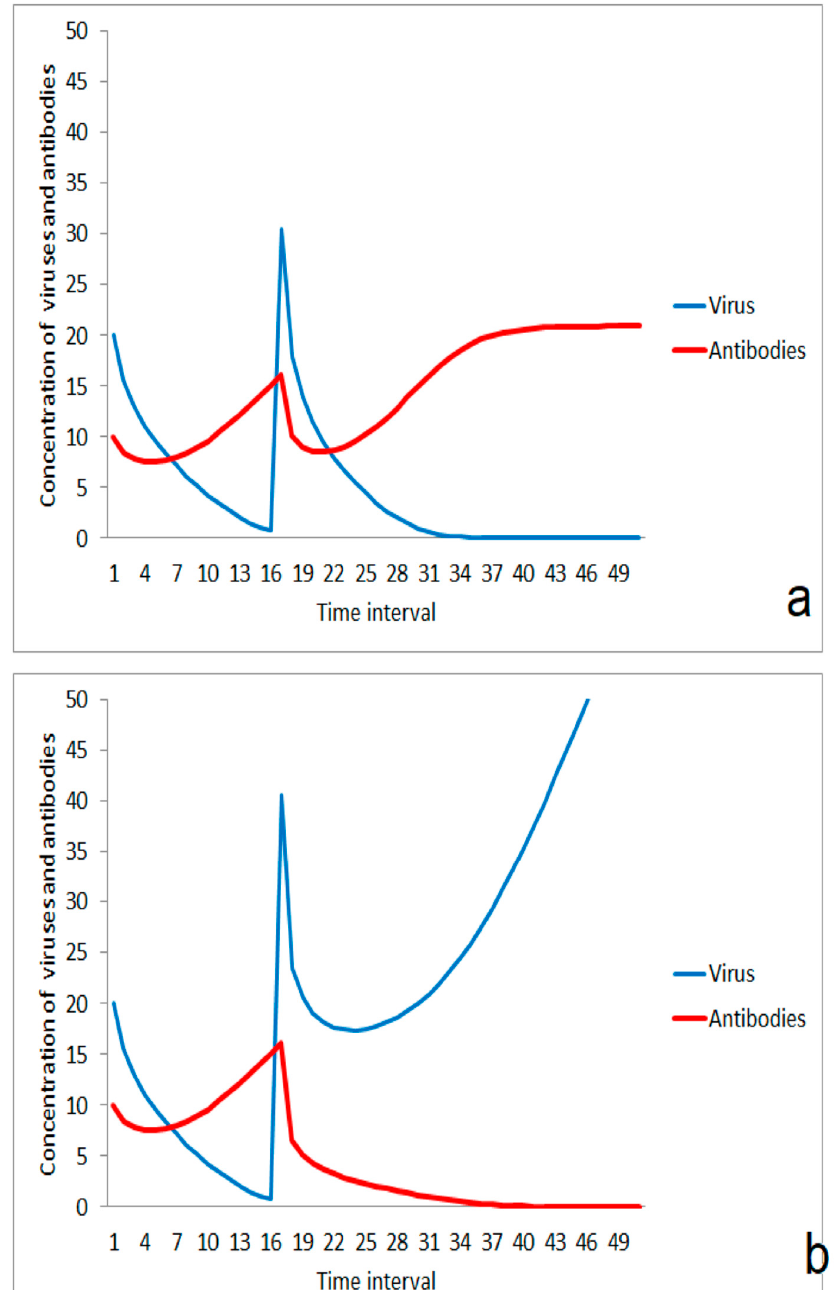
Figure 4. Effect of the strength of second virus impact after induced enhancement of immunization by a first moderate impact: ( a ) suppression of infection after lower second virus impact, ( b ) ongoing disease after higher second virus impact.